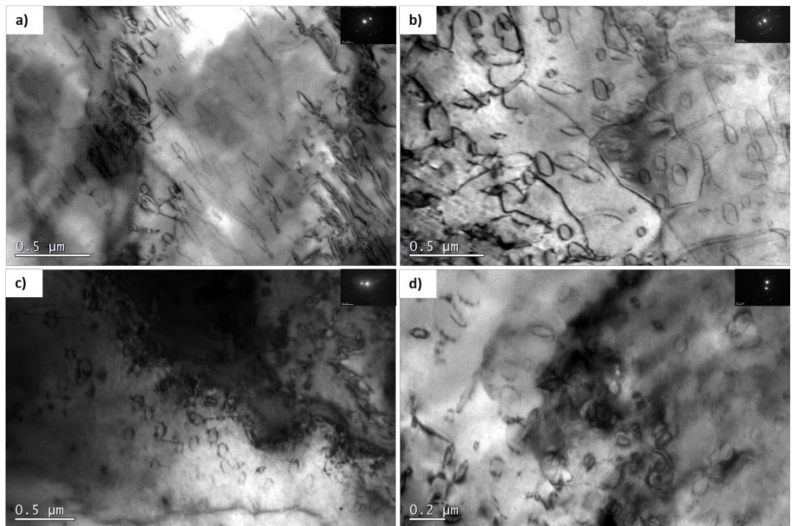
Figure 17. Representative TEM microstructures of the distribution of dislocation loops observed under g vector <112> near {111} zone axis, irradiated with 20 MeV at ( a ) 300 ◦ C, 4.25 × 10 15 ions/cm 2 ; ( b ) 300 ◦ C, 8.5 × 10 15 ions/cm 2 ; ( c ) 450 ◦ C, 4.25 × 10 15 ions/cm 2 ; and ( d ) 450 ◦ C, 8.5 × 10 15 ions/cm 2